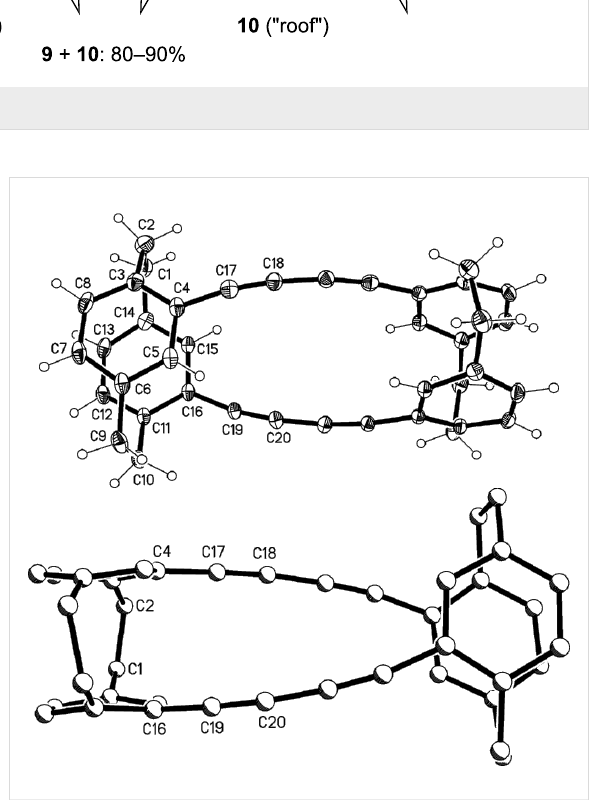
Figure 1: Above: The molecule of compound 11 in the crystal; ellip- soids represent 30% probability levels. Only the asymmetric unit is numbered. Below: Alternative view direction (arbitrary radii, without H atoms) showing the “crossed” geometry via the additional